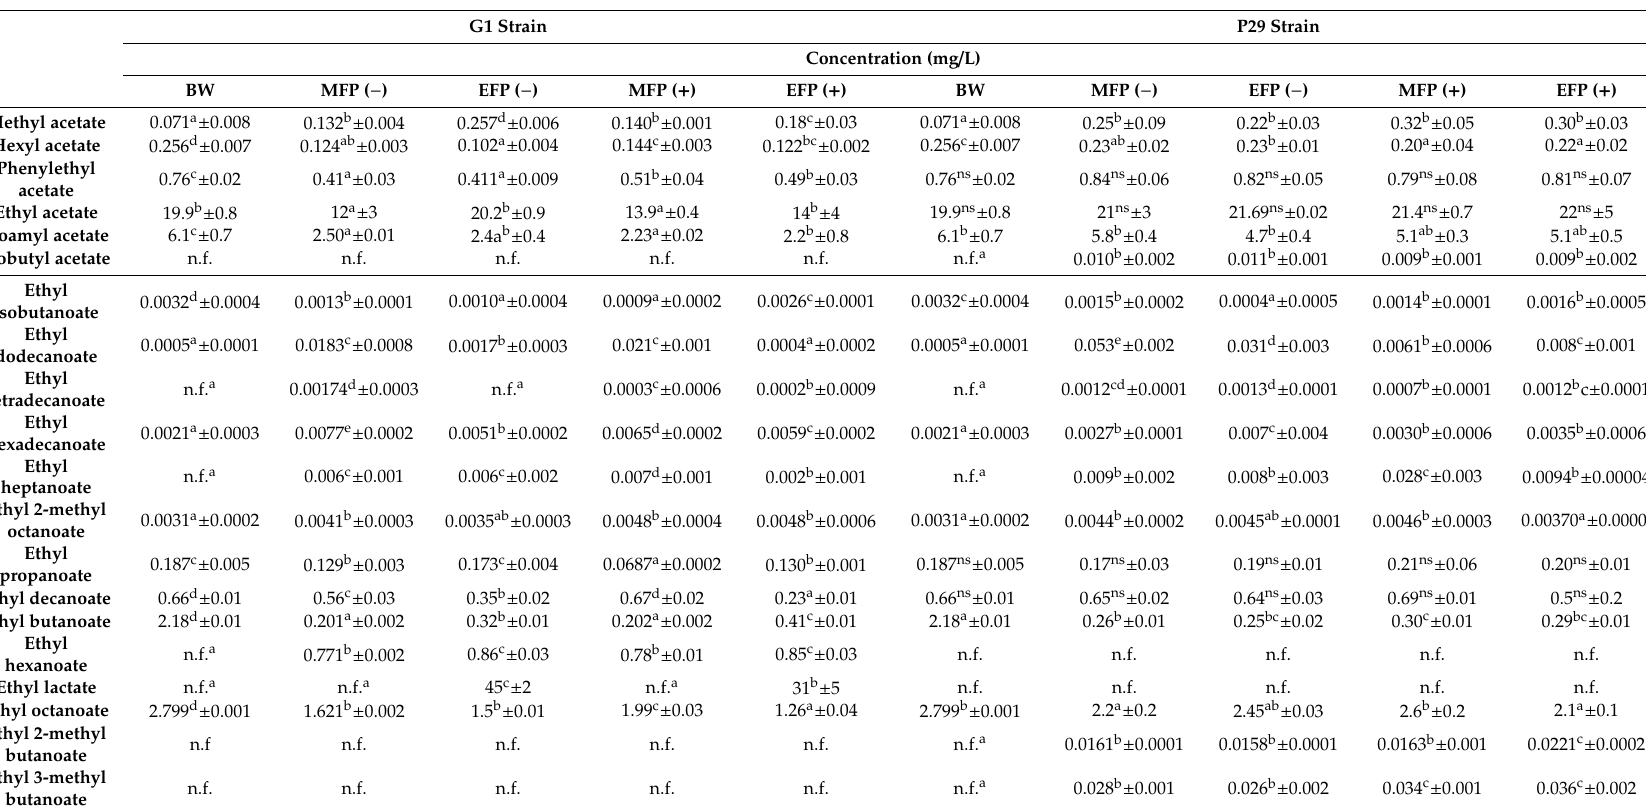
Table 2. Determination of the concentration (mg / L) of esters by gas chromatograph coupled to flame ionization detector (GC-FID) and stir-bar sorptive extraction, followed by thermal desorption and gas chromatography-mass spectrometry